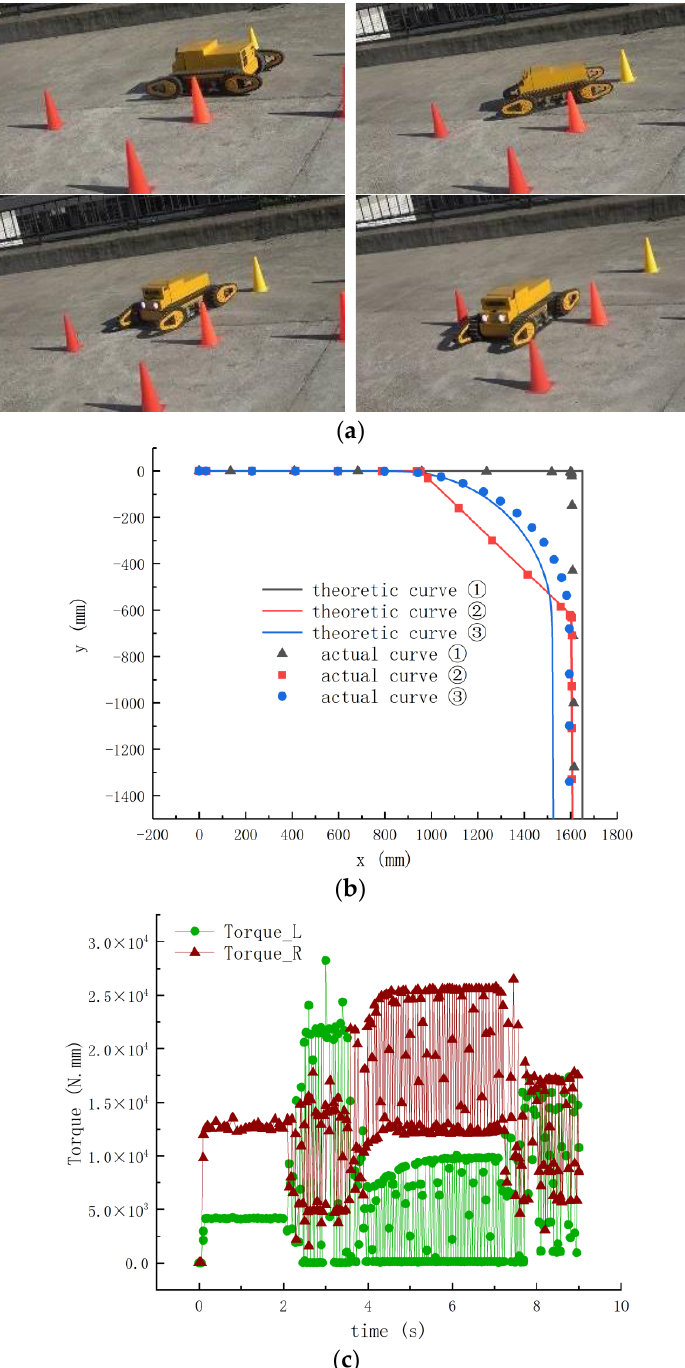
Figure 10. Robot obstacle-avoidance steering performance test. ( a ) Robot obstacle-avoidance steering test process. ( b ) Robot obstacle-avoidance steering trajectory. ( c ) Tracked wheel motor torque in scheme 3.